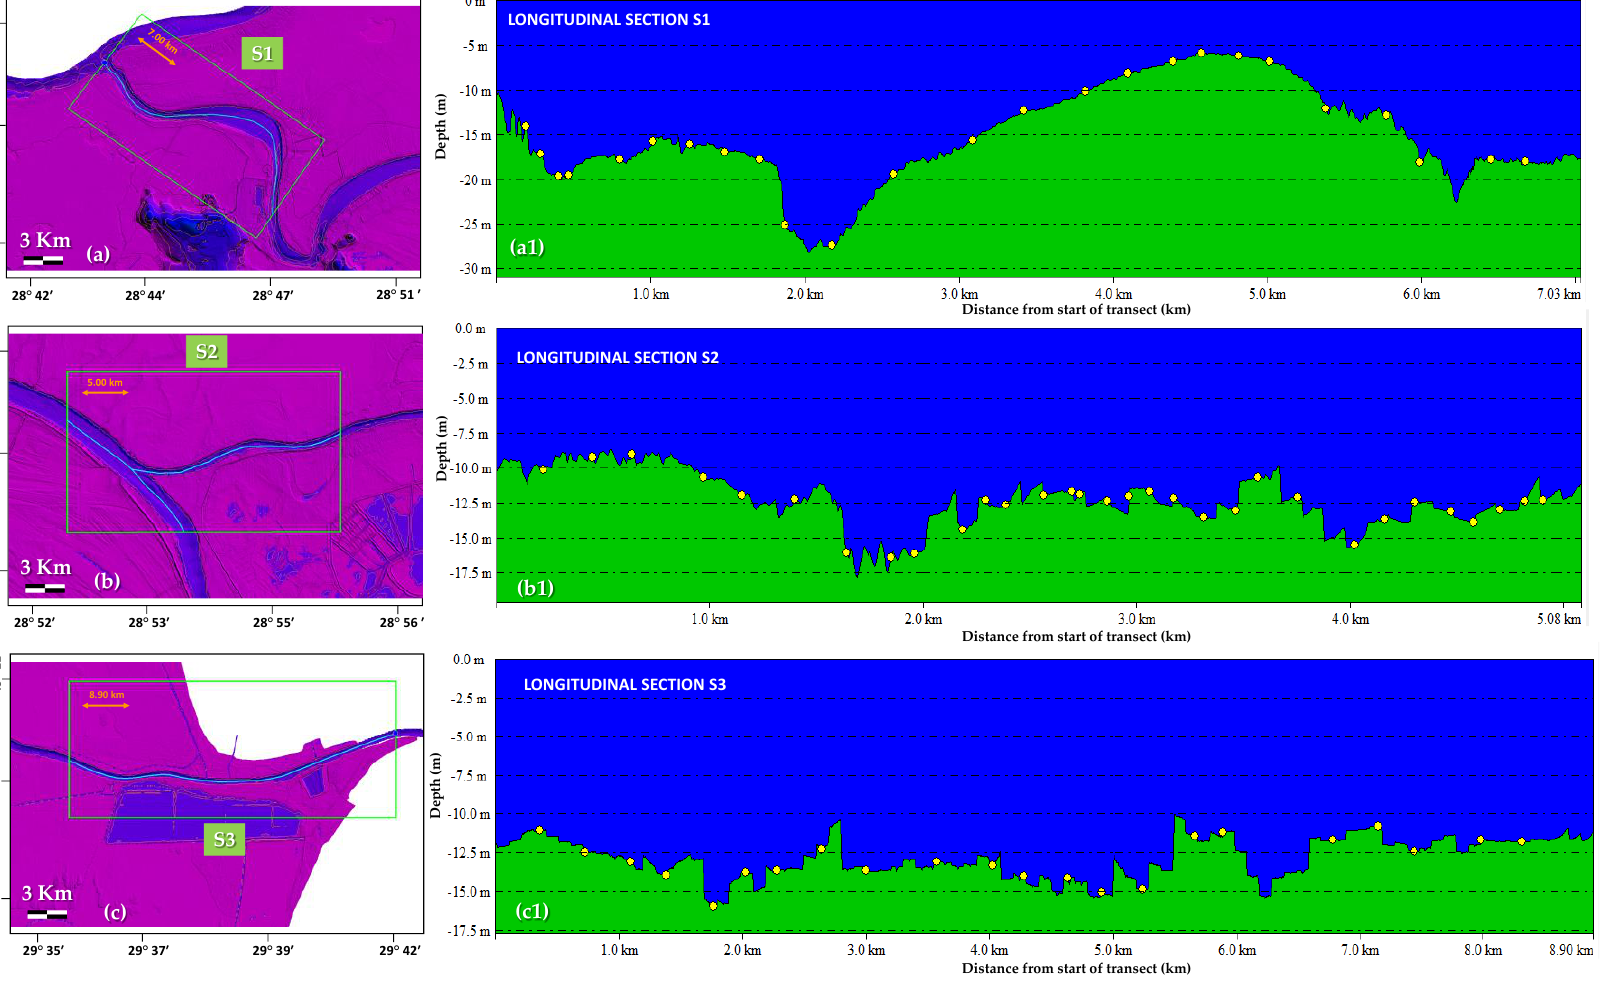
Figure A4. Longitudinal profile of the main channel of all three sections from study area: ( a – c )—the plane view of longitudinal river centerline of S1, S2 and S3 cross-section path; ( a1 – c1 )—section view for the depth profiles of centerline at S1, S2 and S3 river part.